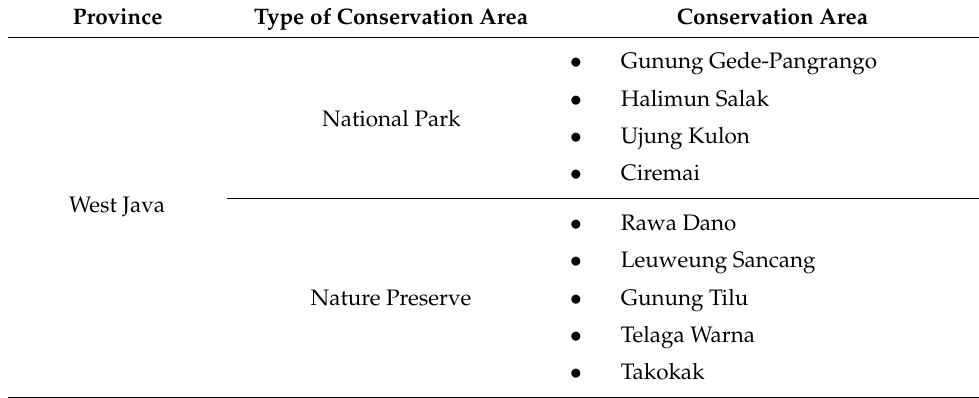
Table A1. Javan leopard highly suitable habitat in conservation